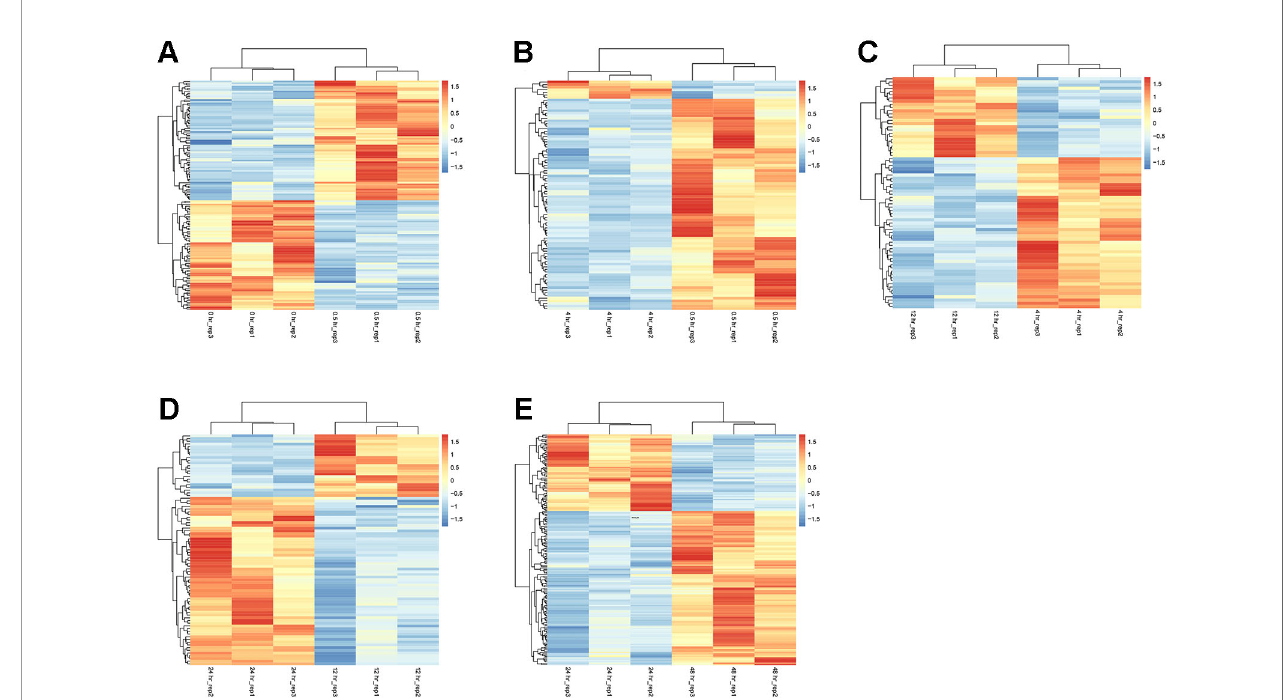
FIGURE 2 | Heatmaps of DEGs between adjacent time points. At each time point, data from three biologically independent samples were included. (A) 0.5 vs. 0 hr; (B) 4 vs. 0.5 hr; (C) 12 vs. 4 hr; (D) 24 vs. 12 hr; and (E) 48 vs. 24 hr. The red color indicates upregulation. The blue color indicates downregulation.